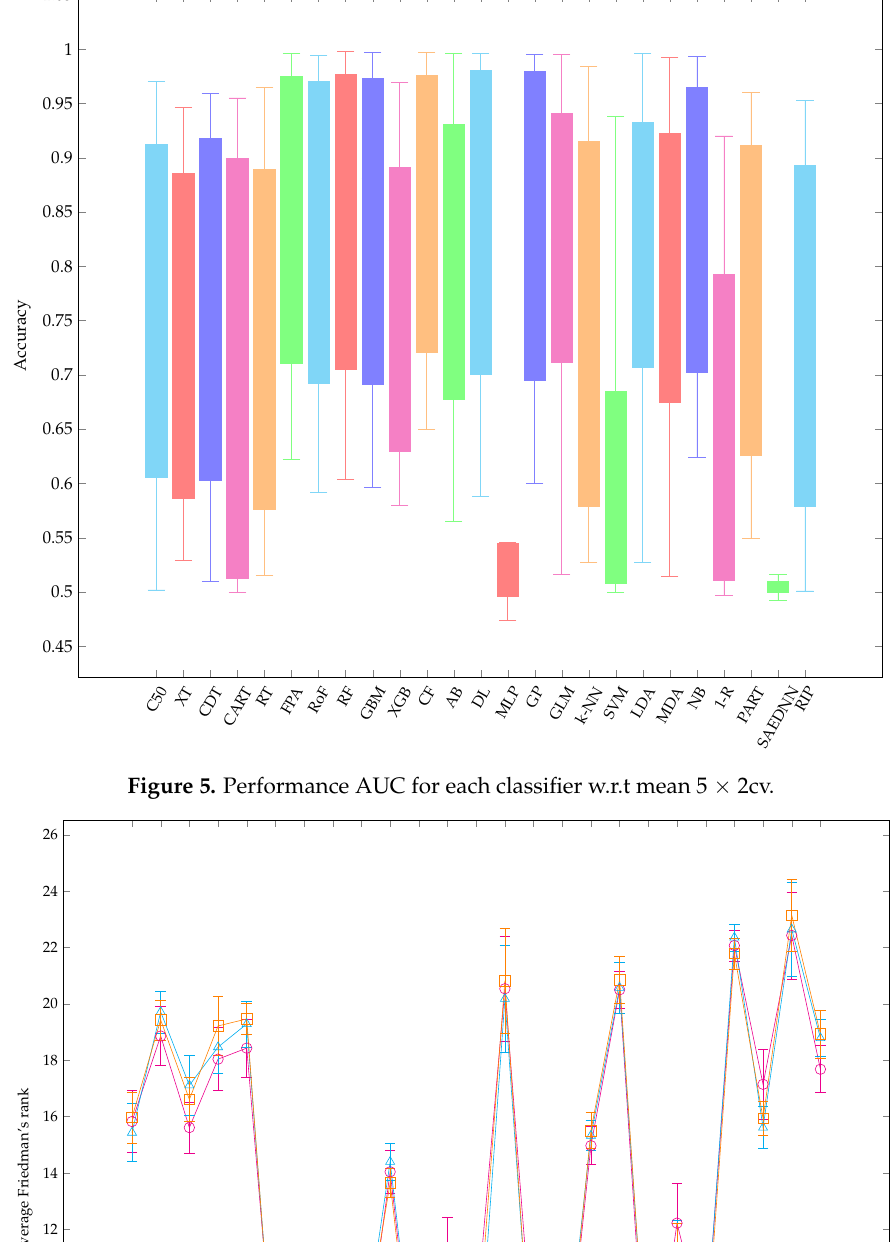
Figure 6. Average Friedman rank of all algorithms for each resampling